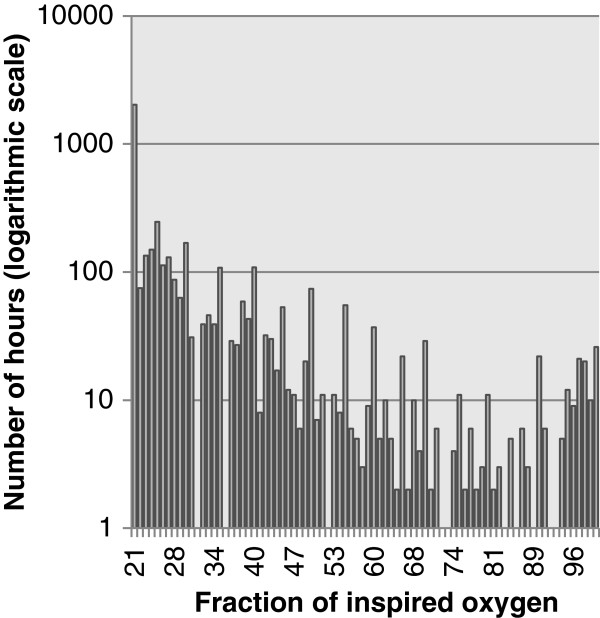
Distribution of FiO2. n = 4428 hours (138 patients).